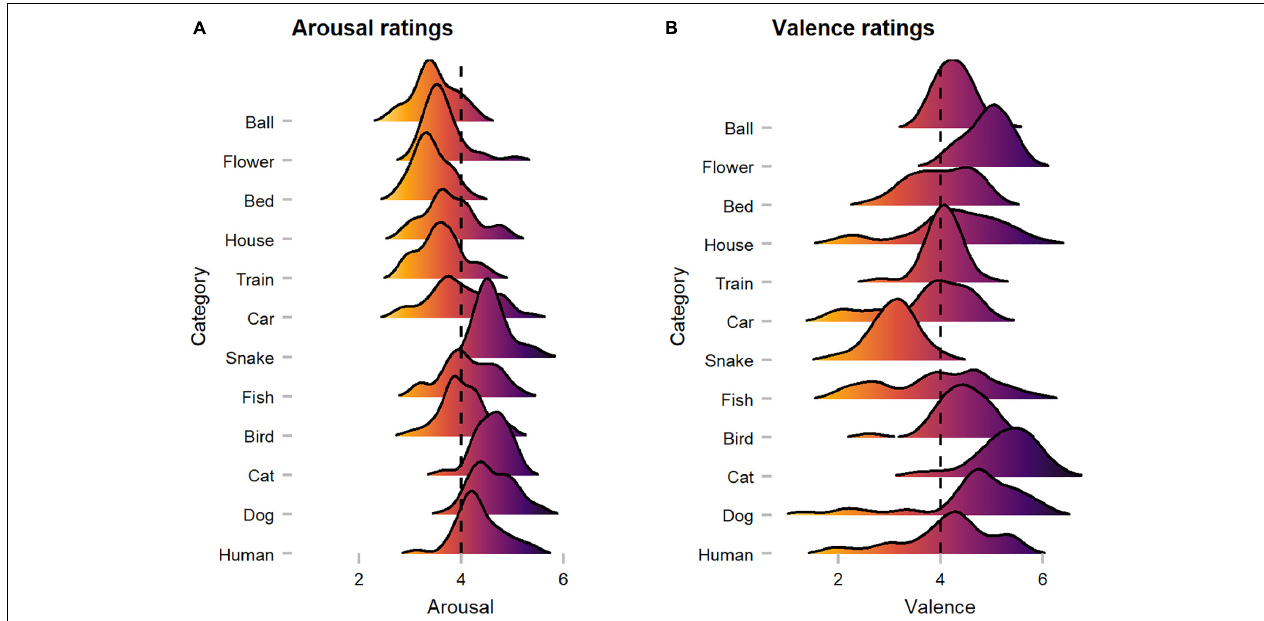
FIGURE 10 | Human observers’ arousal and valence ratings across categories. (A) Arousal ratings showed that animate categories were perceived as more arousing when compared to inanimate categories. (B) Valence ratings suggest category-specific effects (i.e., snake ), as with a few exceptions most images were rated as rather positive. The dotted line represents neutral